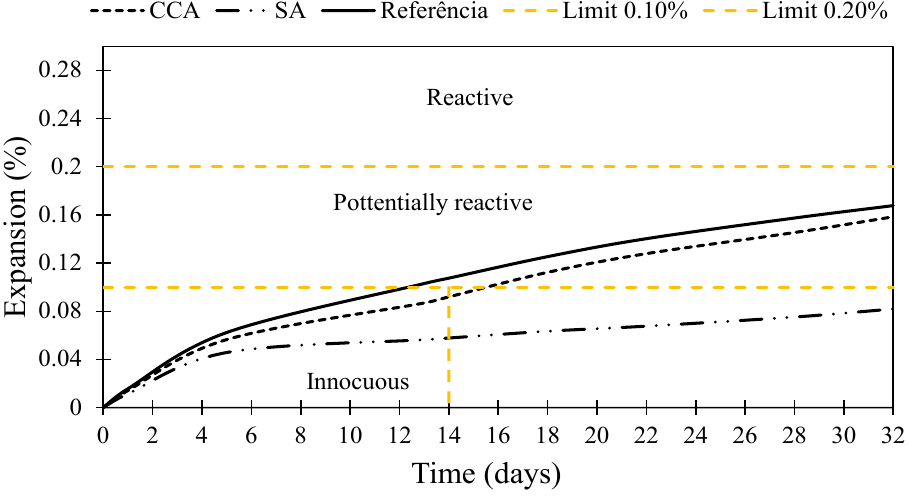
Figure 4. Evolution of the expansion of the mortar bars (AMBT) with 100% cement (Control) compared with 10% replacement of SCM (RHA e SF).